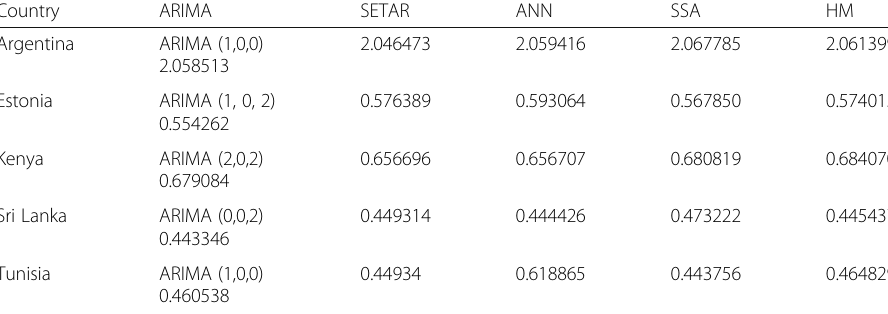
Tunisia ARIMA (1,0,0)